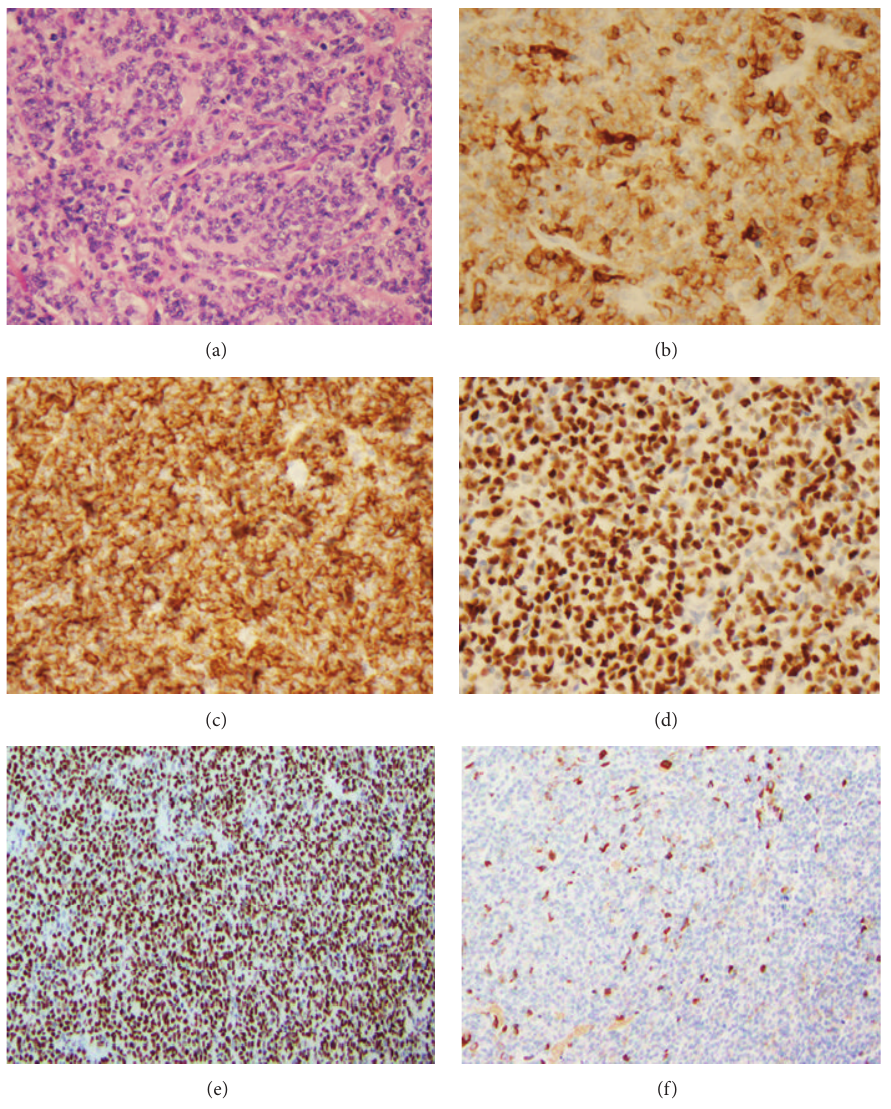
Figure 1: (a) H&E section of the diffuse area. (b) CD7 expression in diffuse areas. (c) CD20 expression in diffuse areas. (d) BCL-6 expression in diffuse areas. (e) BCL-6 expression in follicular area. (f) CD7 negative in follicular lymphoma